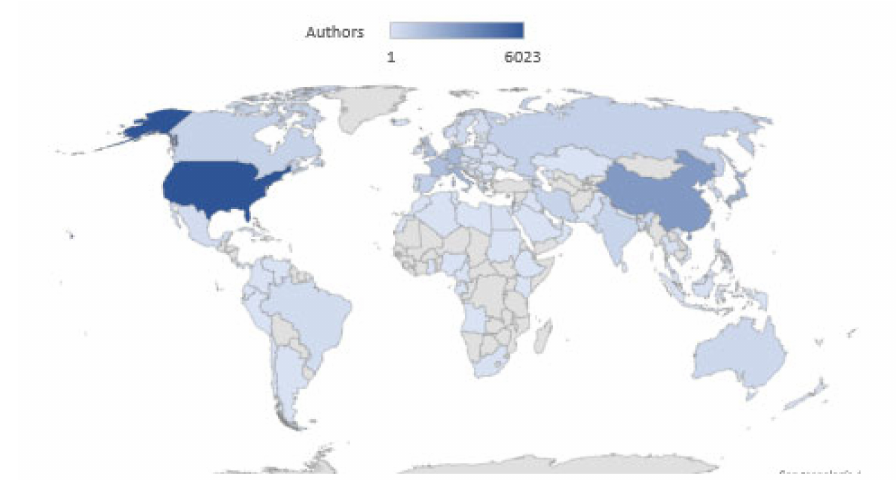
Figure 14. Distribution of authors per